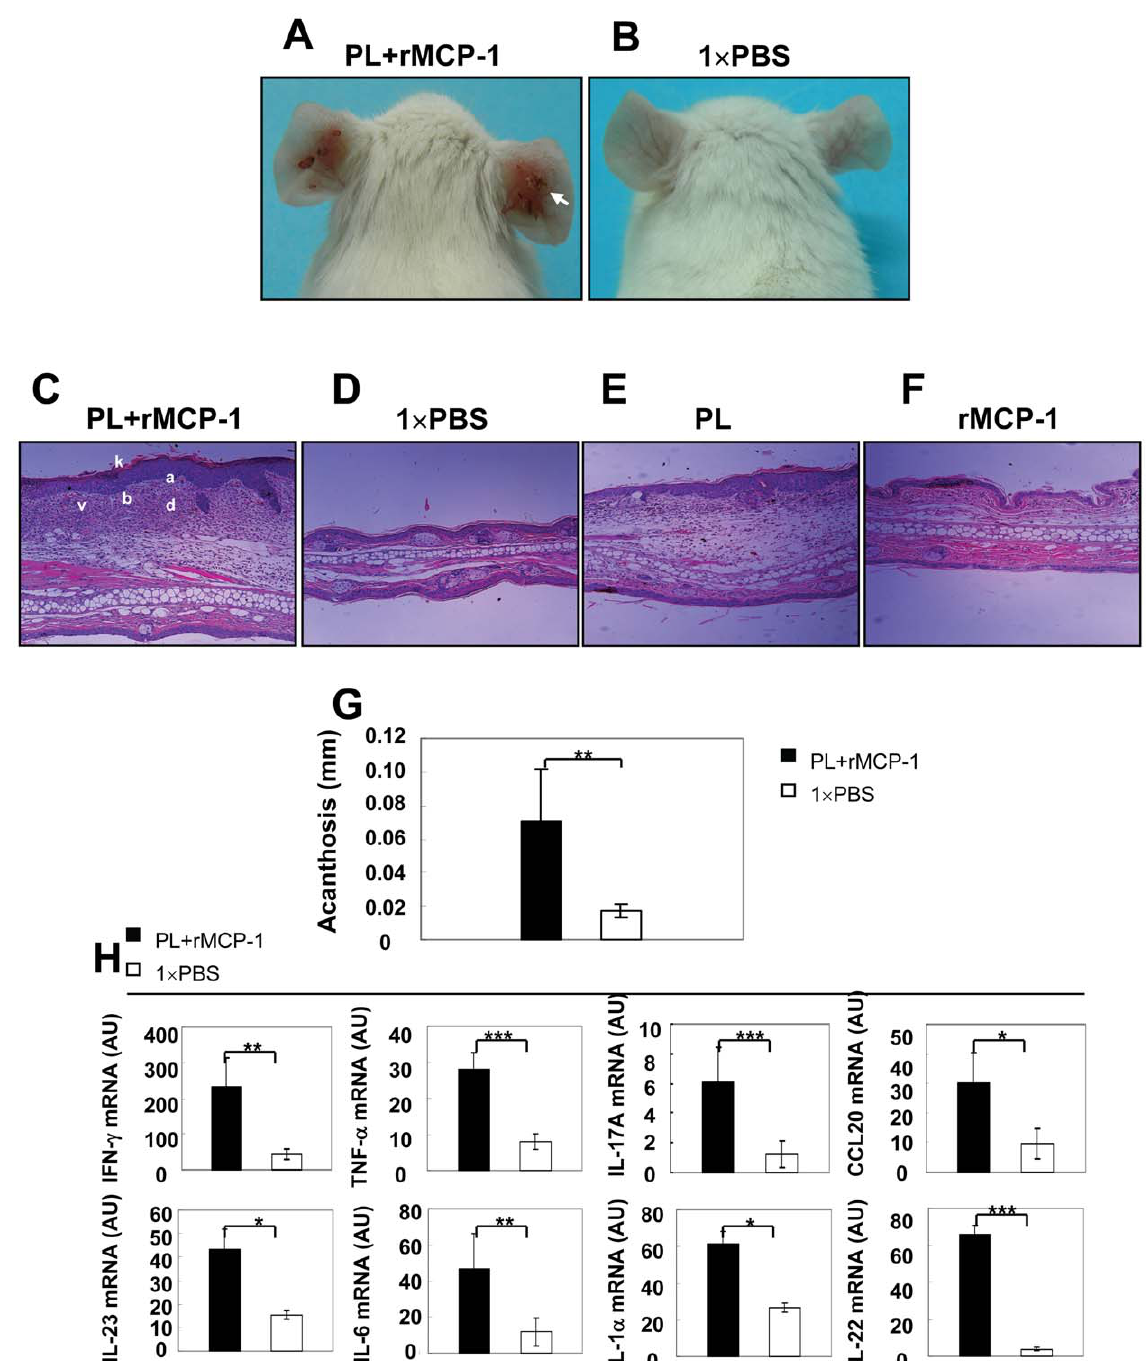
Figure 3. Psoriasiform skin disease induced by PL in mice. The ears of WT BALB/c mice were injected intradermally every other day for 28 days with 30 m l 1 6 PBS either containing 1.5 m g PL and 30 ng recombinant murine MCP-1 or alone. ( A, B ) Representative clinical features of ears of treated mice. White arrow indicates severe erythema, scales and crusts. ( C–F ) H&E staining of ears of from mice treated with PL + rMCP-1, 1 6 PBS, PL and rMCP-1. k, hyperparatosis with intracorneal neutrophilic pustule; a, acanthosis; b, increased proliferative basal layer epidermal keratinocytes; d, dermal cell infiltrate; v, dilated dermal blood vessels. Original magnification, 6 100. ( E ) Microscopic changes of ears quantified using acanthosis. ( F ) Real-time RT-PCR analysis of ears with indicated treatments. * p , 0.05, ** p , 0.01, *** p , 0.001, Student’s t test. doi:10.1371/journal.pone.0016483.g003 patients with psoriasis displayed CCR6 [32]. We have found that injection of PL and rMCP-1 is capable of triggering production of well documented by the observation of expression of CCR6 and CCL20 in psoriatic lesions [13] and by the finding that both IL- CCL20 and IL-23 together with slight ear skin inflammation in 17A- and IL-22-producing cells isolated from lesional skin of CCR6 2 / 2 mice, suggesting that macrophages, DCs or kerati-